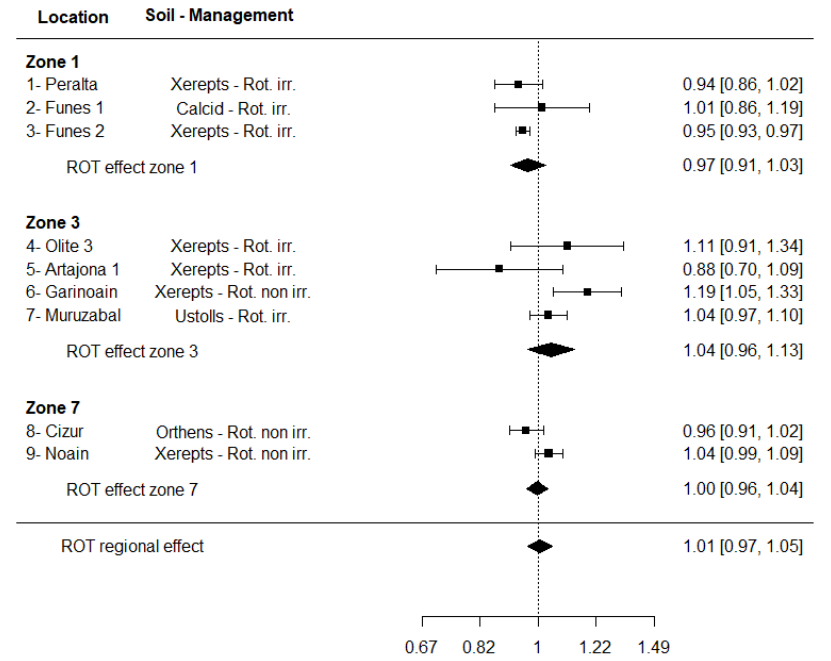
Figure 7. Response ratio (RR) of BD (0–30 cm) for the adaptive management strategy of crop rotations (ROT). Zones correspond to those in Figure 1. The effect was considered significant when the 95% confidence interval (CI) of the RR did not overlap one ( α = 0.05). Soil and management column includes information about principal soil group and irrigation regime in each group.